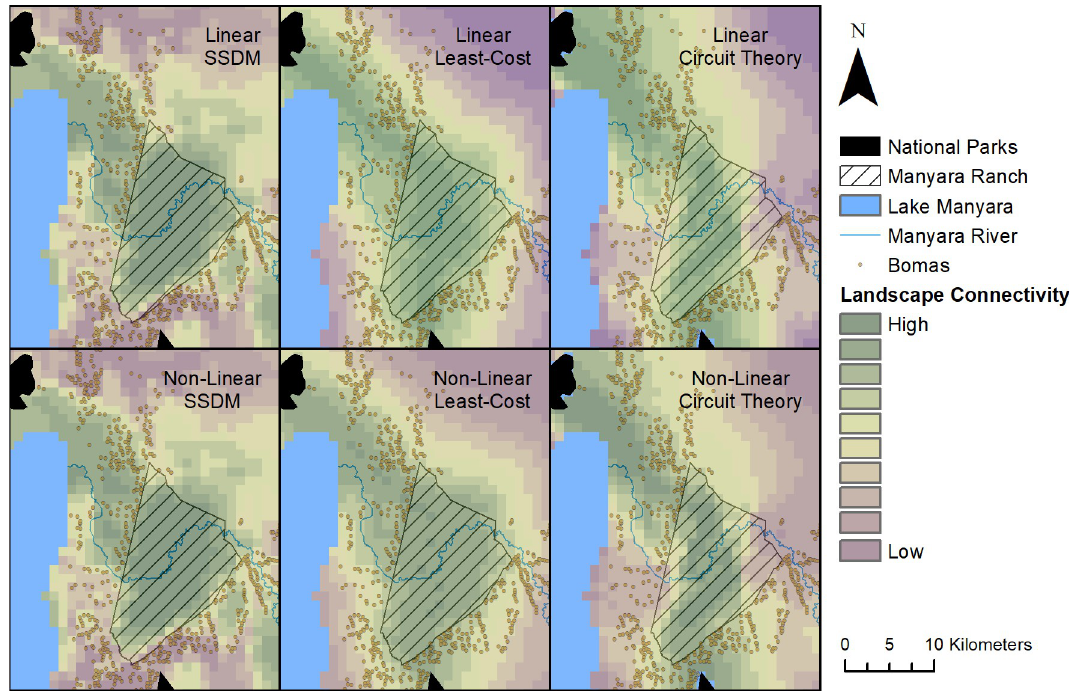
Fig 2. Predicted habitat suitability and least-cost and circuit theory-based landscape connectivity maps for the stacked species distribution model output in both linearly and non-linearly scaled layers. Bomas are shown to illustrate the influence of human presence on predicted habitat suitability in the study area